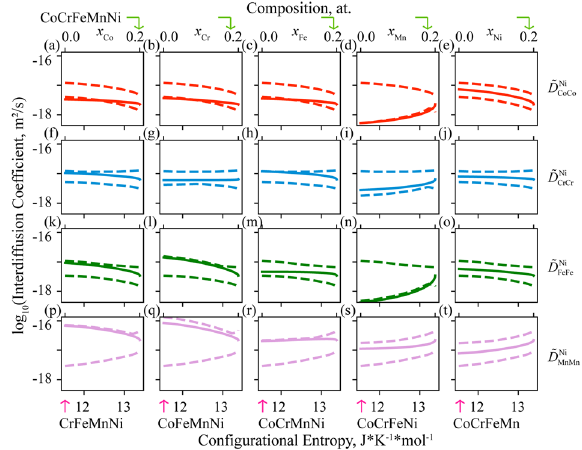
Fig. 10 Projections of interdiffusion coef fi cients along different composition coordinates. The dash lines refer to the bounds of the related interdiffusion coef fi cients ( ~ D Ni 1073 K, while the solid lines are related to interdiffusion coef fi cients due to the maximum